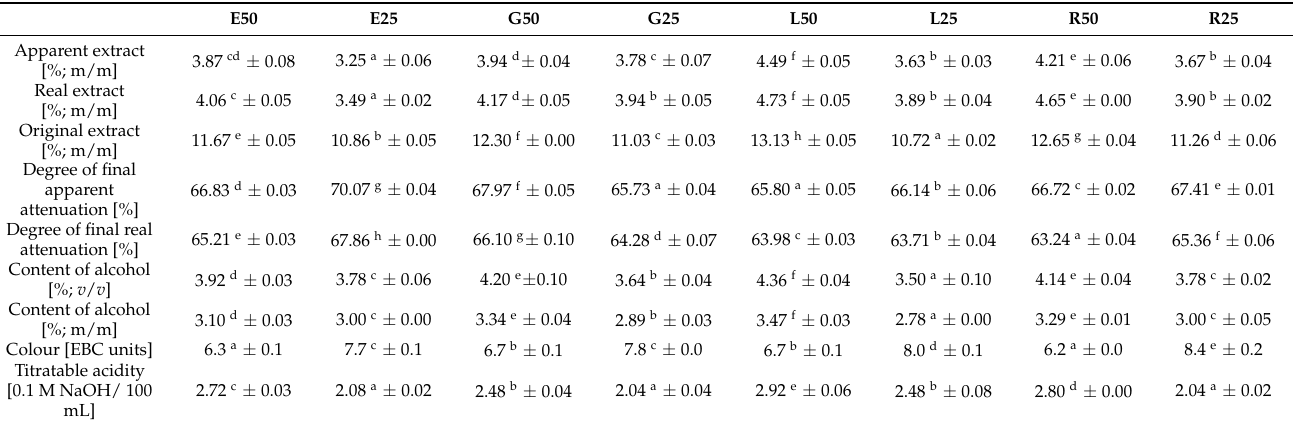
Table 1. Results of the physicochemical analysis of Witbier-style wheat